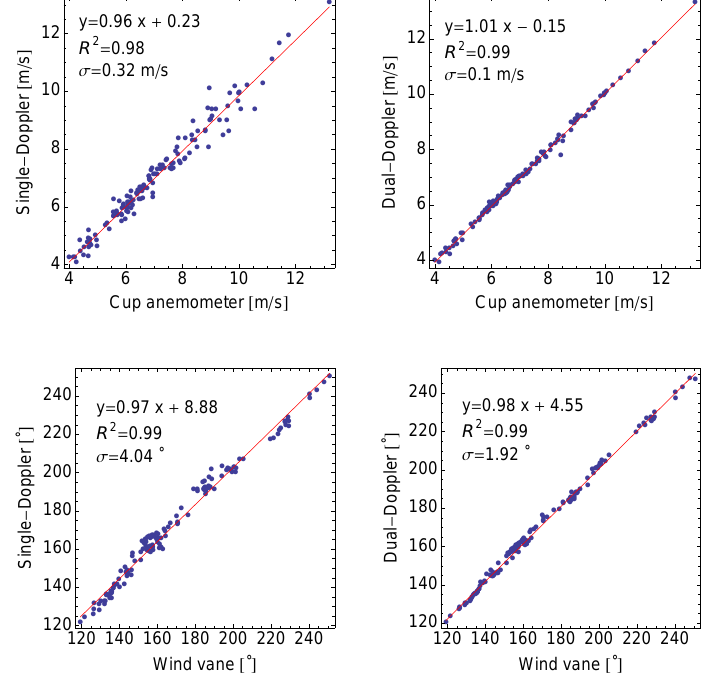
Figure 9. The horizontal wind speed and wind direction simultaneously retrieved with the long-range WindScanner system operated in the single- and dual-Doppler mode expressed as 10-min